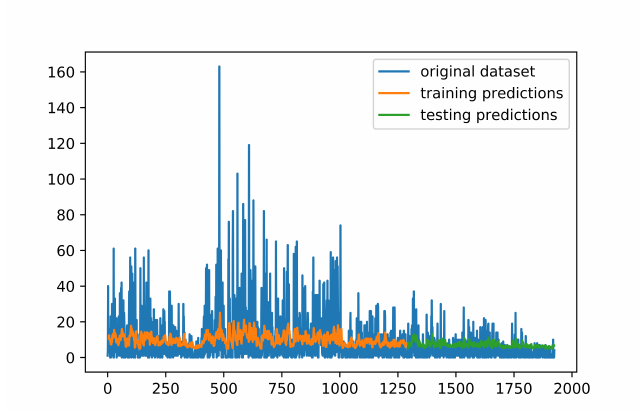
Figure 7. Time series of number of small earthquakes between two subsequent large earthquakes and corresponding training and validation predictions in Experiment 4